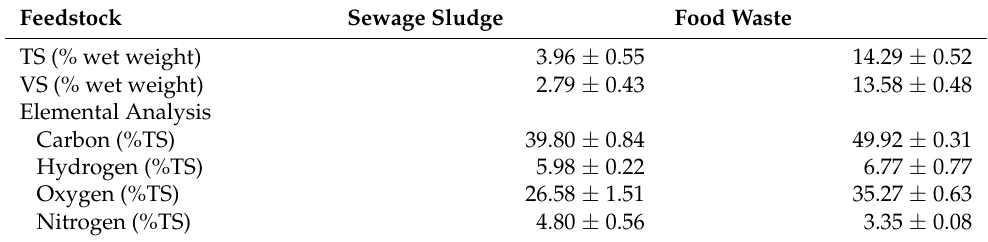
Table A2. Characterisation results of the feedstocks used in the biomethanation experiments.